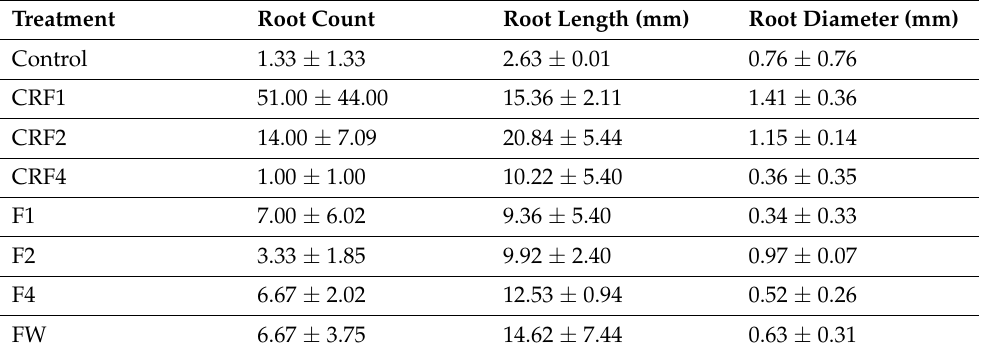
Table 2. Root growth parameters measured in March 2020 at a depth of 0–15.7 cm. A one-way analysis of variance (ANOVA) with a Tukey honestly significant difference (HSD) test was used to determine significant differences between means. Data represents means ± standard error.